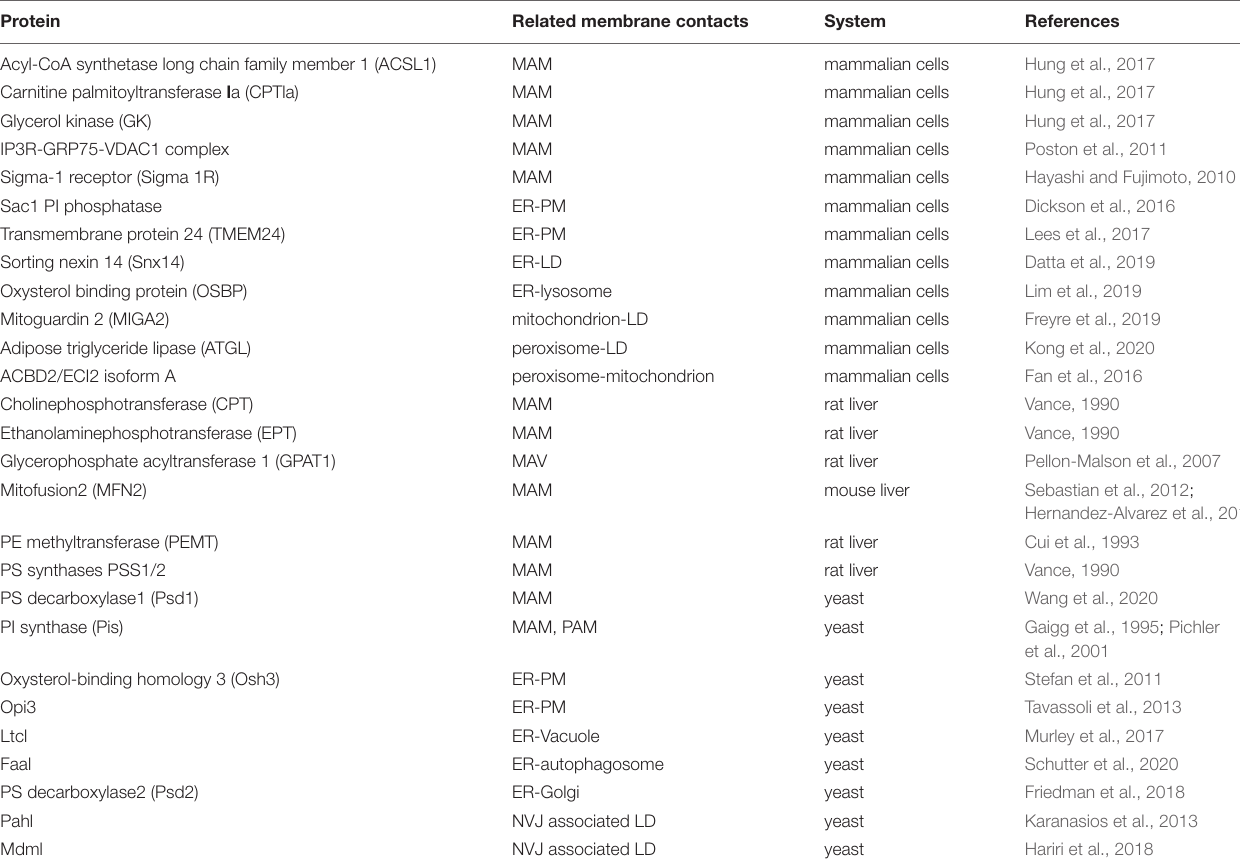
TABLE 1 | Proteins involved in lipid metabolism at